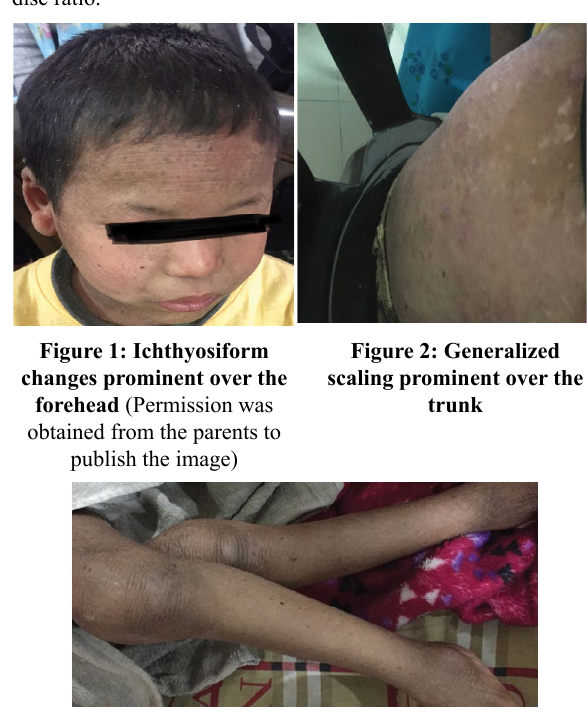
Figure 3: Spastic diplegia showing scissoring gait Laboratory investigations that included complete blood count, renal function test, liver function test, thyroid function test, urinalysis, creatine kinase level were normal. With all the presenting findings, the patient was diagnosed as Sjögren– Larsson